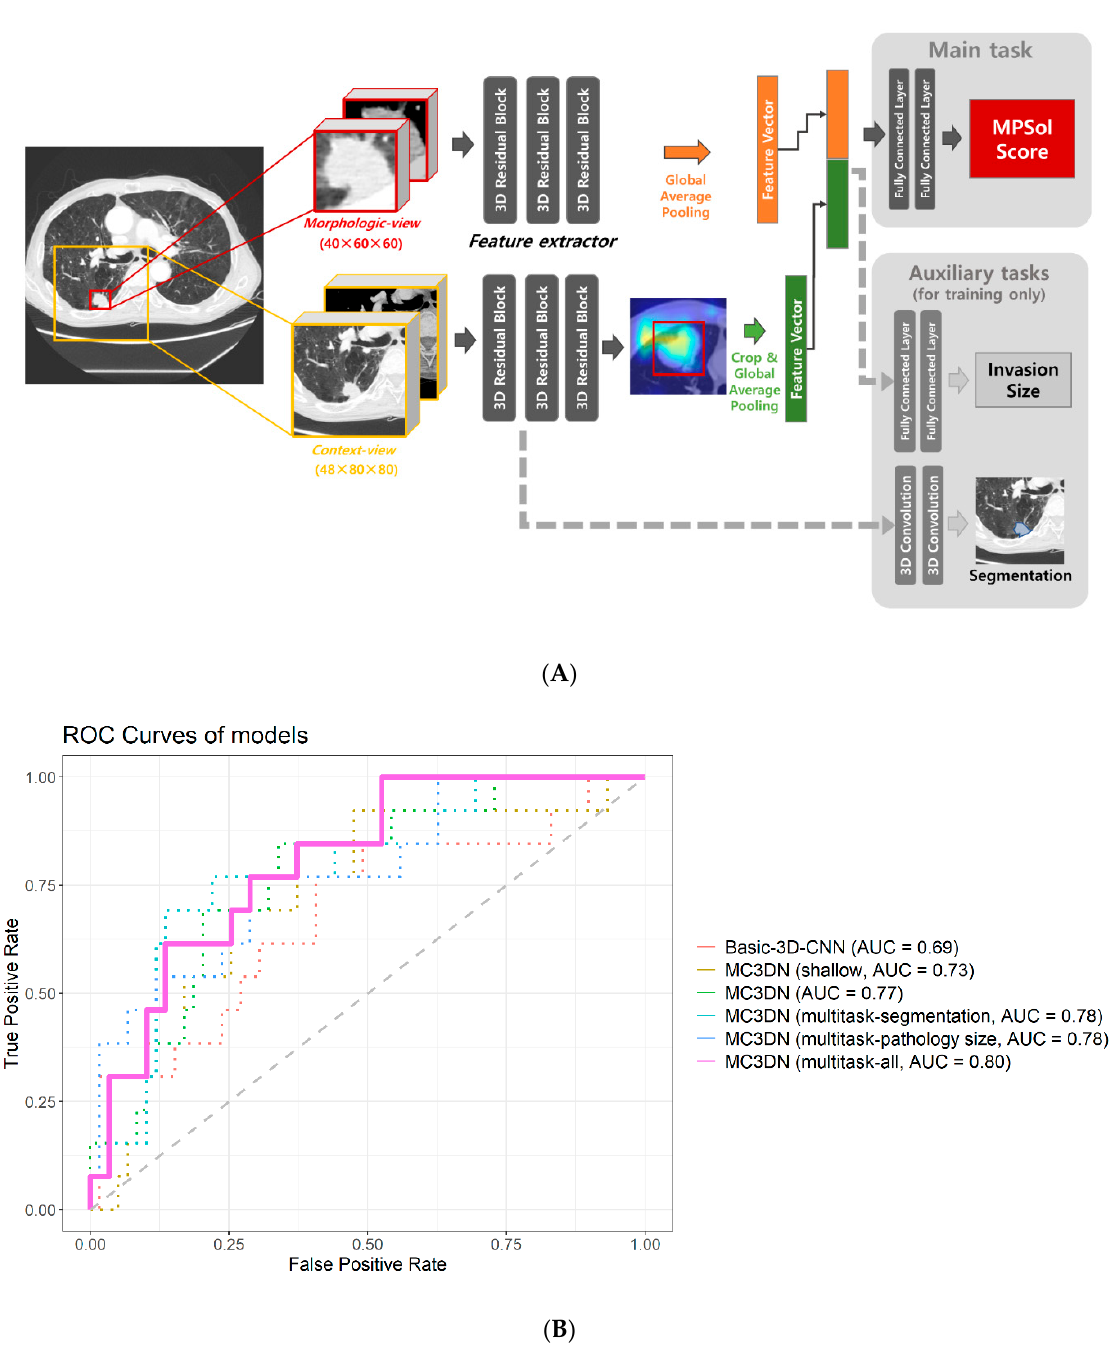
Figure 2. ( A ) Deep learning workflow. ( B ) Performance of the model. ROC curves generated from different models to predict any high-grade pattern of lung ADCs. The basic-3D-CNN model takes only one 3D patch from target lesion with a model architecture consisting of one residual block for each level (AUC = 0.69). The Morphologic-view Context-view 3D network (MC3DN) is introduced. The MC3DN (shallow) model takes both the context and morphologic views from the target lesion while having the same model architecture as Basic-3D-CNN (AUC = 0.73). A larger model architecture is adopted for MC3DN with three residual blocks for each level (AUC = 0.77). A multitasking strategy is applied with the segmentation task and pathology size prediction task, respectively, on MC3DN (AUC = 0.78). Finally, both of the tasks are applied on MC3DN simultaneously (AUC = 0.8).